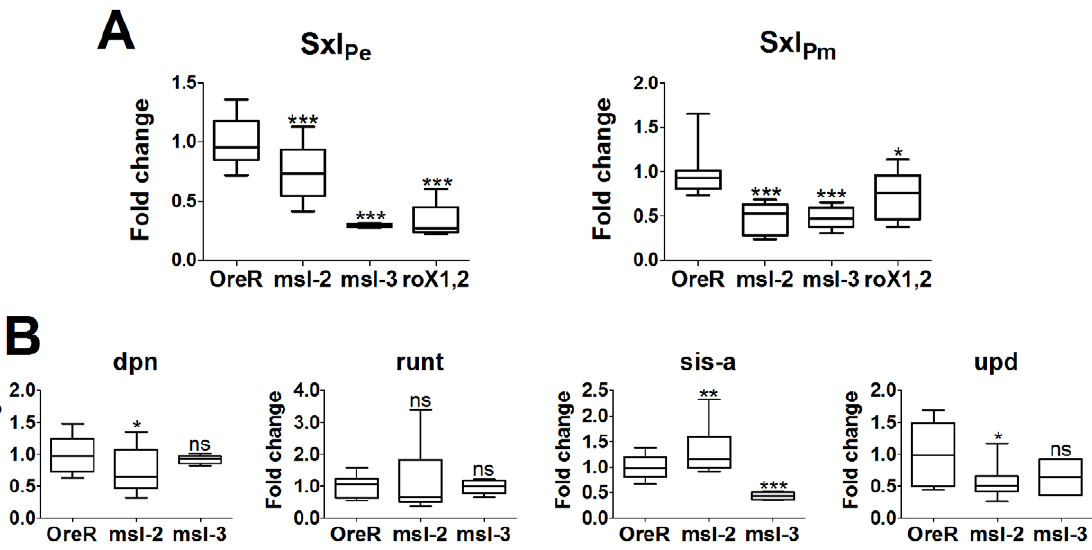
Figure 7. Change in mRNA expression for dosage compensated and control genes compared to Ore R. All replicates are plotted and display the 25 and 75 percentiles (boxed), median (line in boxes), max and min (whiskers) of the data set. Significance is measured using an unpaired t-test with a Welch’s variance correction, levels indicated above whiskers as *** for p , .001, ** for .001 , p , .01, * for .01 , p , .05, and ‘ns’ for p . .05. (A) Sxl Pe and Sxl Pm transcripts show a highly significant drop in expression when DCC function is compromised by mutation in msl-2, msl-3 or the roX genes. Embryo genotype on the x-axis. As noted in the text, the lower significance in the change in Sxl Pm levels for the roX- genotype is most likely the influence of males which have a wild type roX2 gene. (B) dpn and run , show almost no significant change in expression, with the slight exception of dpn in the msl-2 1 mutants. sis-a and upd show significant change in a DCC-compromised backgrounds, with specific differences between mutant genotypes. sis-a shows the expected drop in expression for msl-3 1 embryos but shows a slight increase in expression for msl-2 1 embryos. This appears to arise from an additional role of MSL-2, affecting mRNA levels (see Figure S1). upd is affected by the loss of MSL-2 but is essentially unaffected by the loss of MSL-3, as would be expected for a gene with close DCC entry sites.